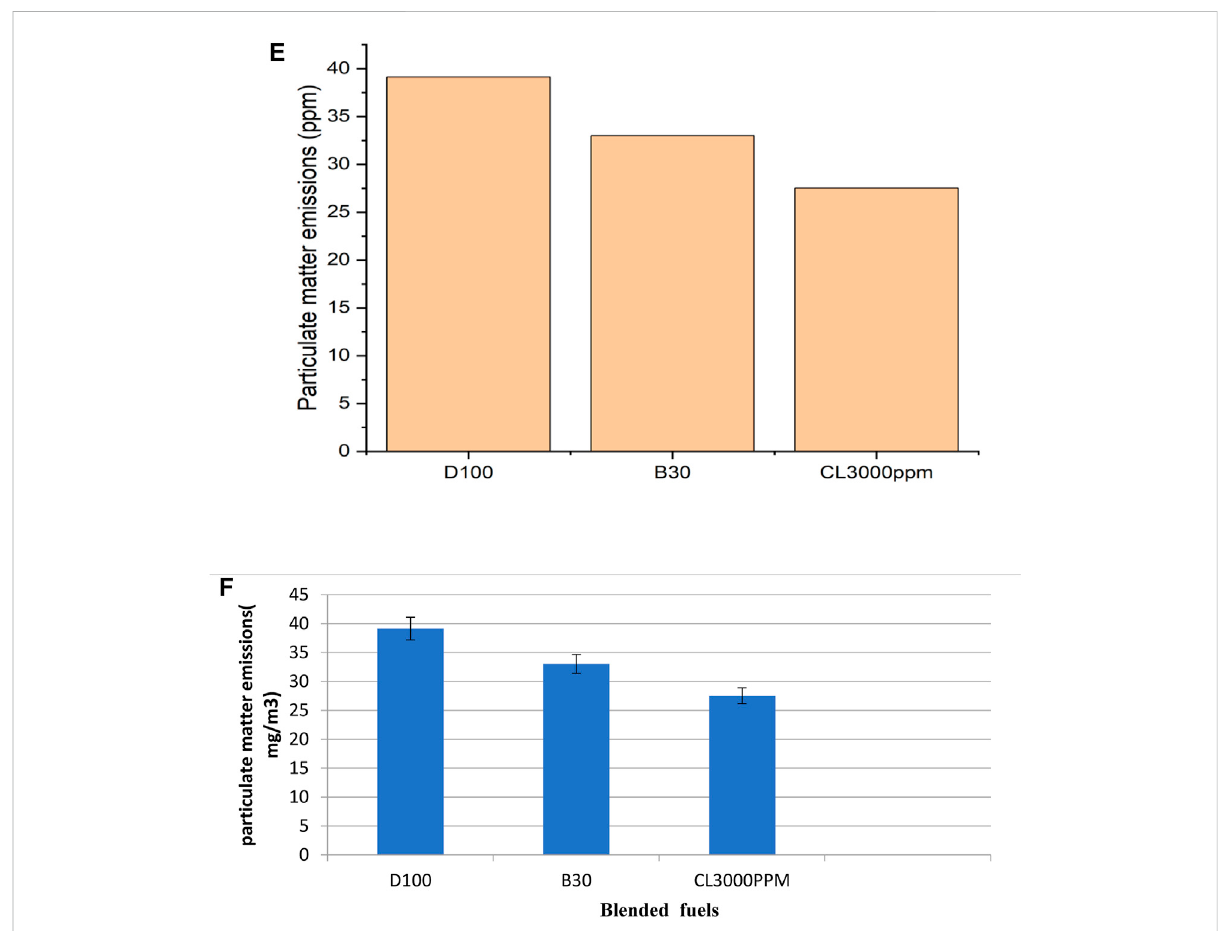
FIGURE 6 (A – D) : Particulate emission matter vs. brake power. (E) Comparative results of different blended fuels. (F) Average error of particulate matter emission.